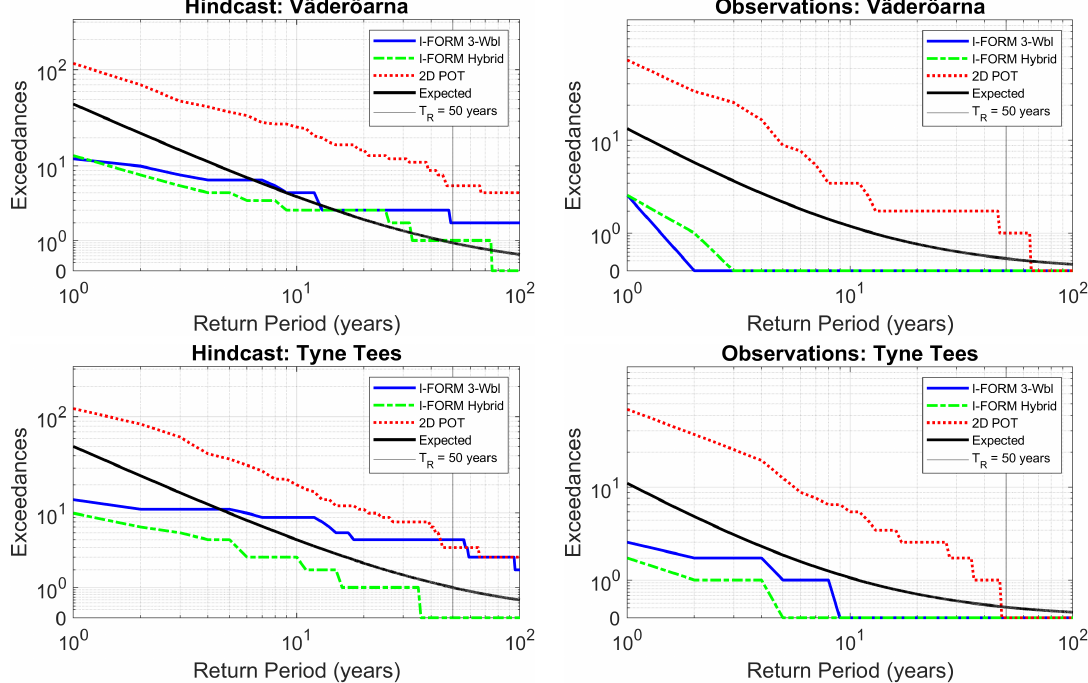
Figure 13. Number of independent (decorrelated) sea states which exceed the contour lines in the region above the 95-percentiles of H s and steepness s . Also shown is the expected—in a statistical sense—number of events for the 2D POT method. The return period which is used in this study, 50 years, is highlighted with a vertical gray